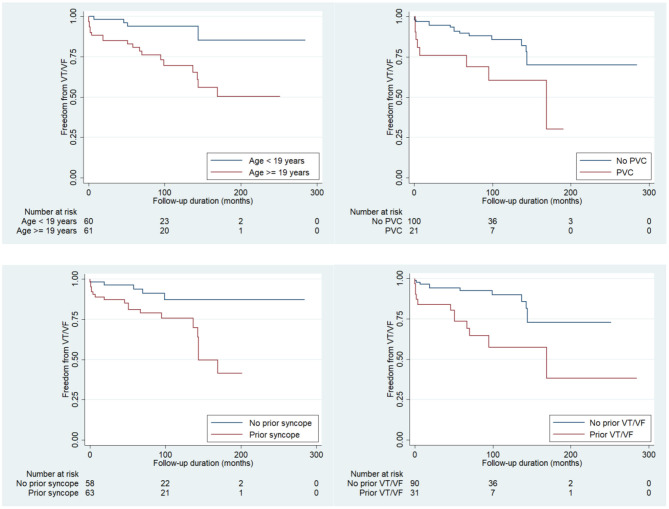
Kaplan-Meier survival curves demonstrating freedom from spontaneous ventricular tachycardia/ventricular fibrillation (VT/VF) during follow-up stratified by age ≥19 years of age (top left), PVC (top right), initial presentation with syncope (bottom left), initial presentation with VT/VF (bottom right). All showed significant difference between the two groups by the log-rank test.